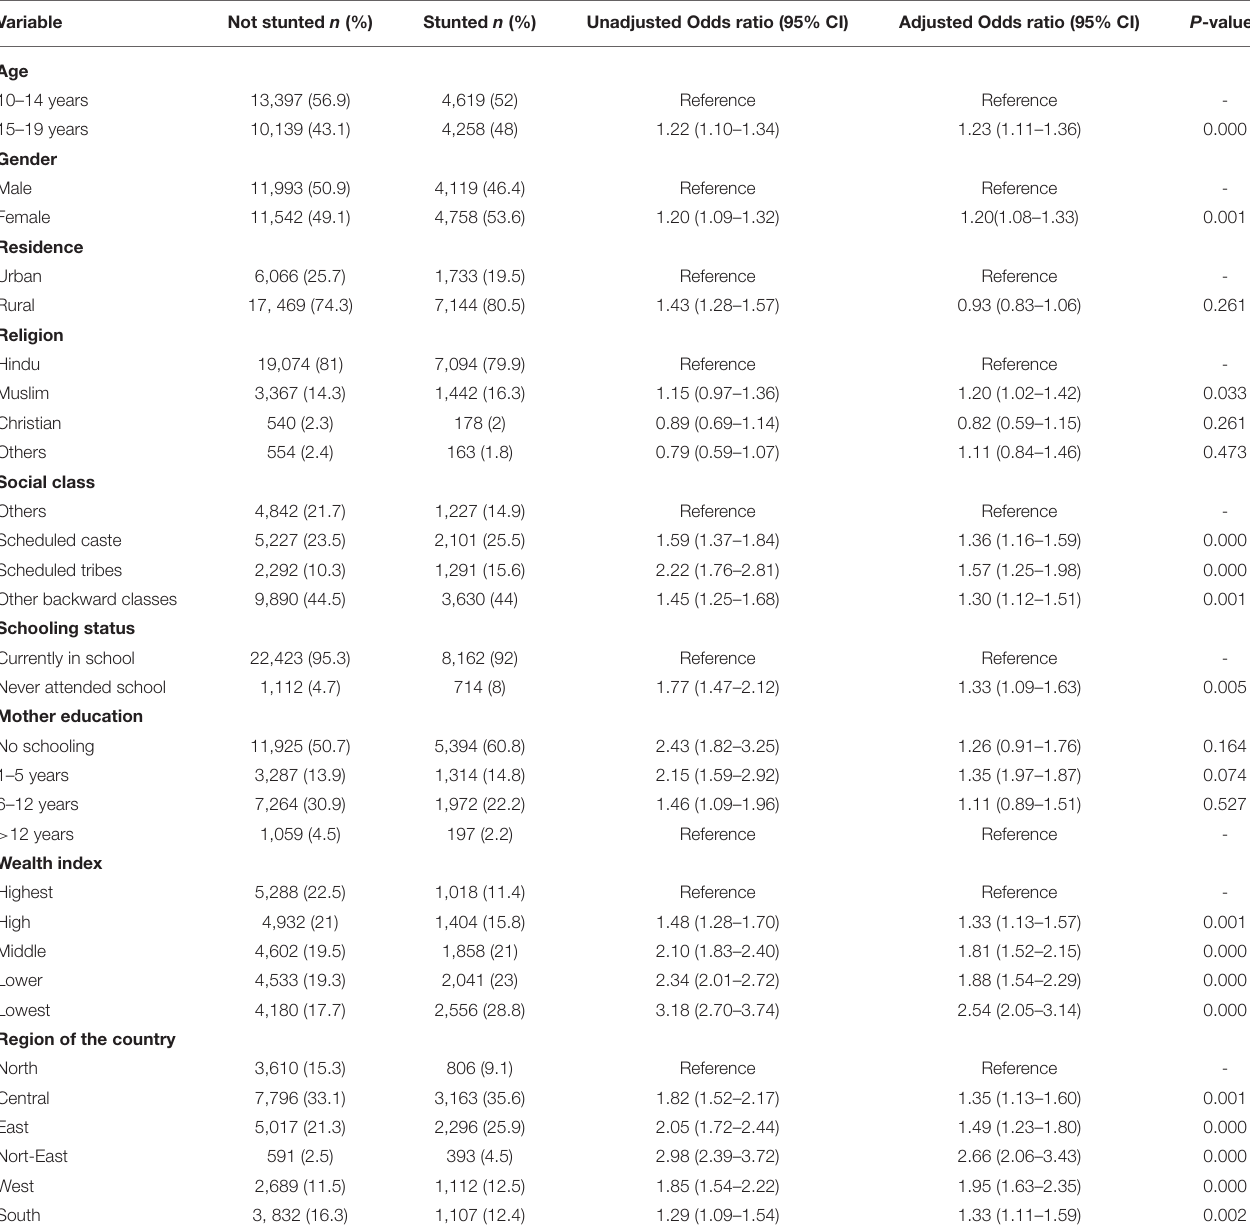
TABLE 2 | Predictors of stunting among adolescent children (10–19 years) of India through Logistic regression model (weighted N = 32,412).